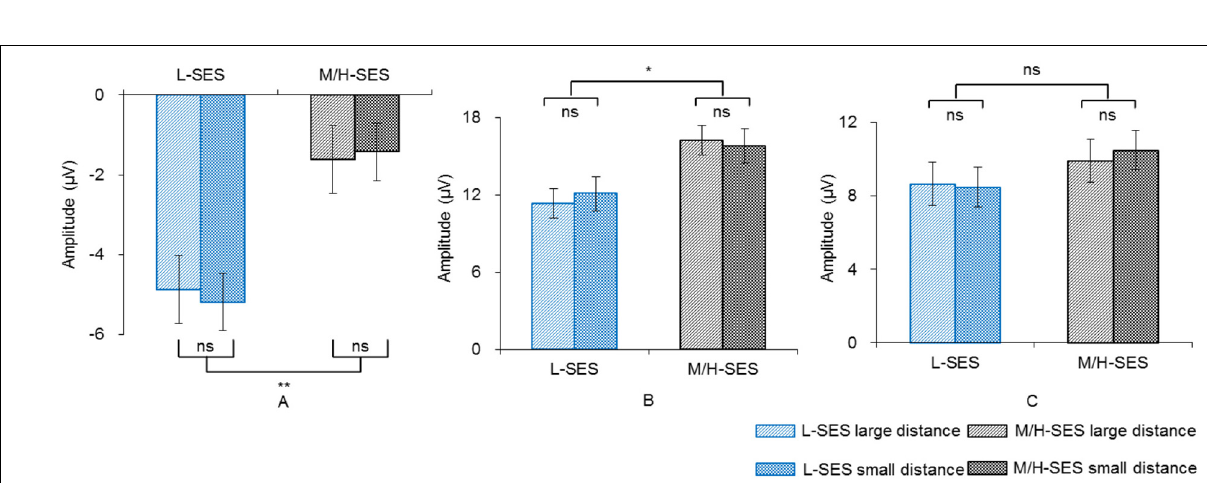
FIGURE 2 | The grand average ( n = 32) for the different SES groups in each electrode that to be analyzed.